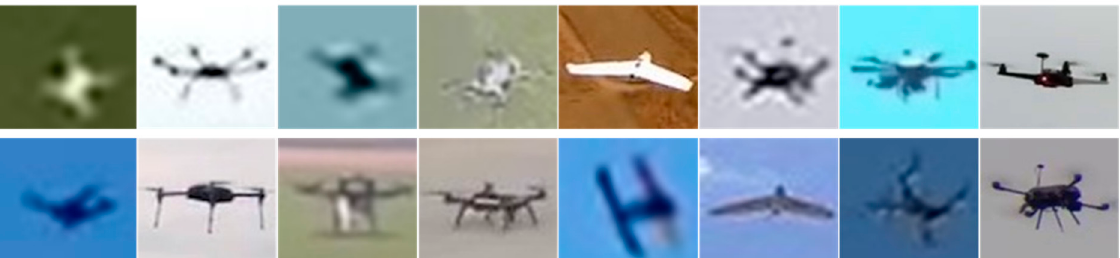
Figure 4. Sample images of some UAV in the UAVSwarm dataset.